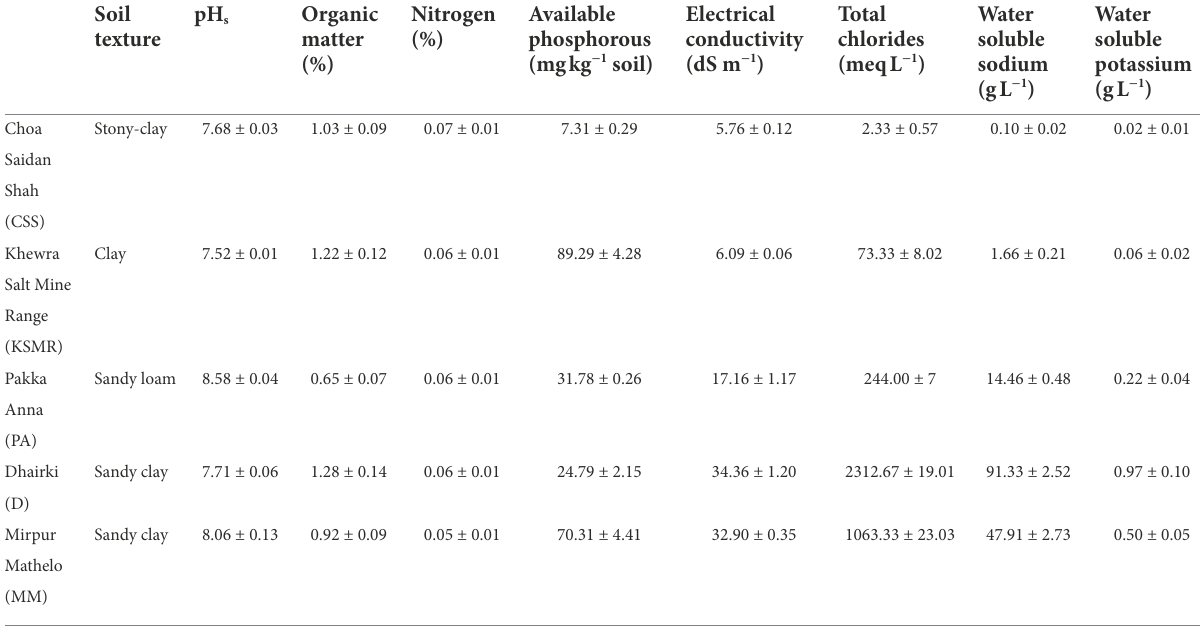
TABLE 1 Texture and chemical properties of soil samples collected from five farms in the Indus Basin Region, Pakistan.